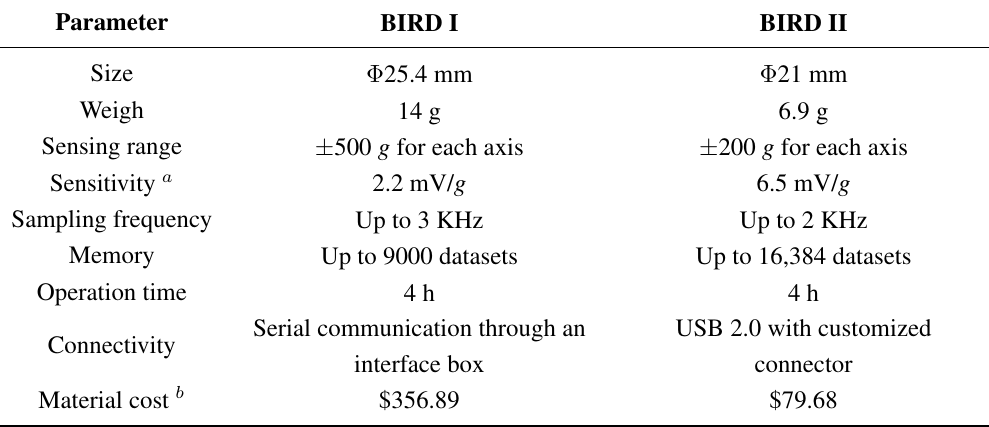
Figure 1. Connection between the Berry Impact Recording Device II (BIRD II) and the PC through a USB cable with a customized connector in the sensor end. The diagram is not drawn to scale. 1, BIRD II; 2, PC and BIRD II PC software. Table 1. Comparison between BIRD I and BIRD